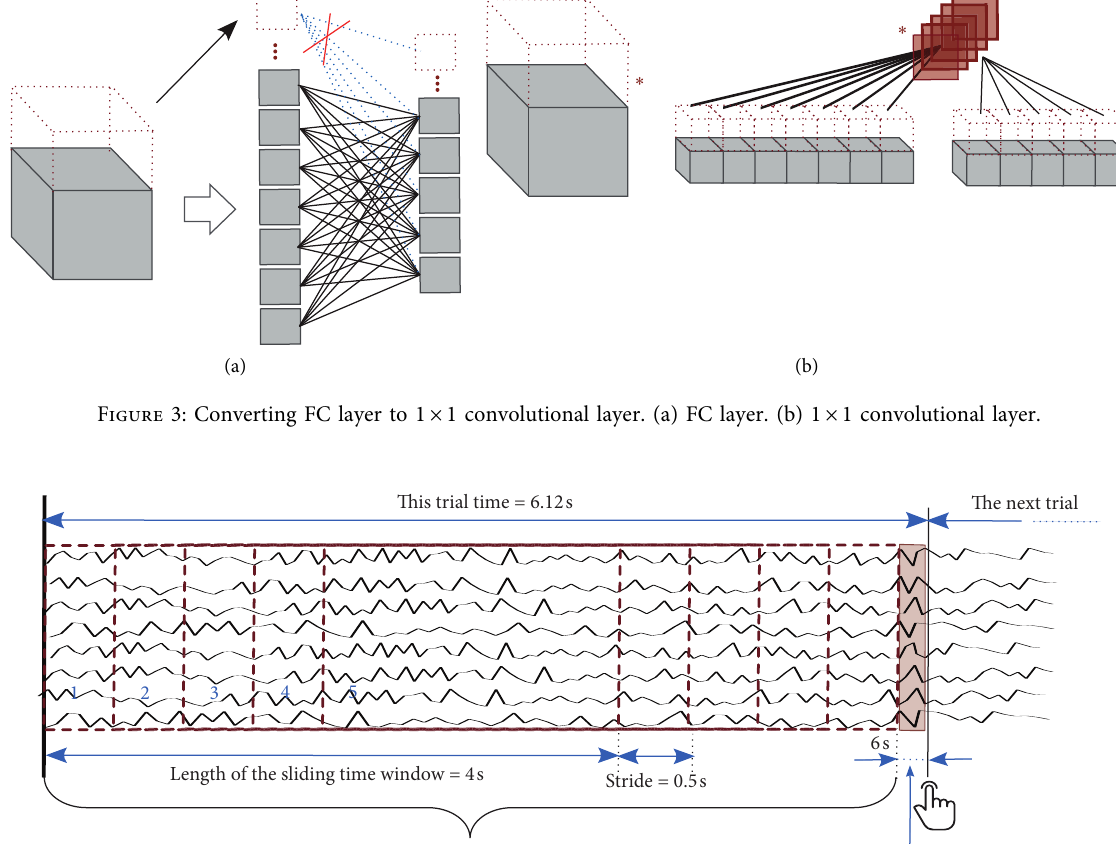
Length of the sliding time window = 4s